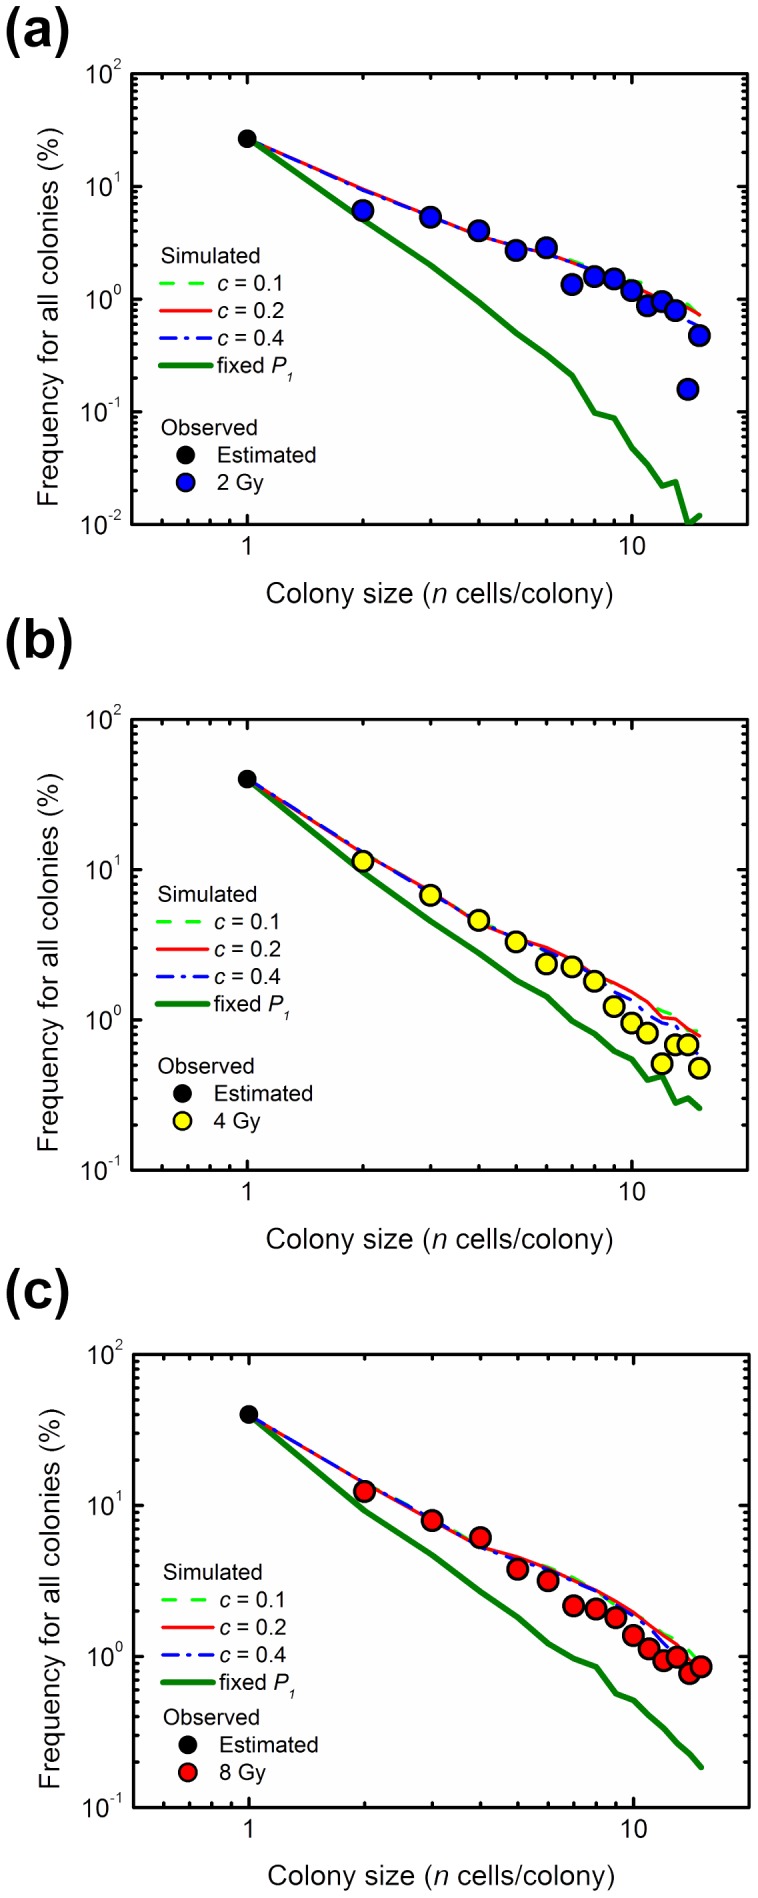
Simulated colony size distribution of irradiated abortive clones.The abortive colony size distributions at 2, 4 and 8 Gy are shown in panels (a), (b) and (c), respectively. Circles demonstrate the experimentally determined size of colonies, and lines represent the simulated colony size distribution with the specific slope c (0.1, 0.2 and 0.4) using the parameters of the log-log fit. The data of the fixed P1 shows the result of the simulation using the P1 (g = 0) at all generations.